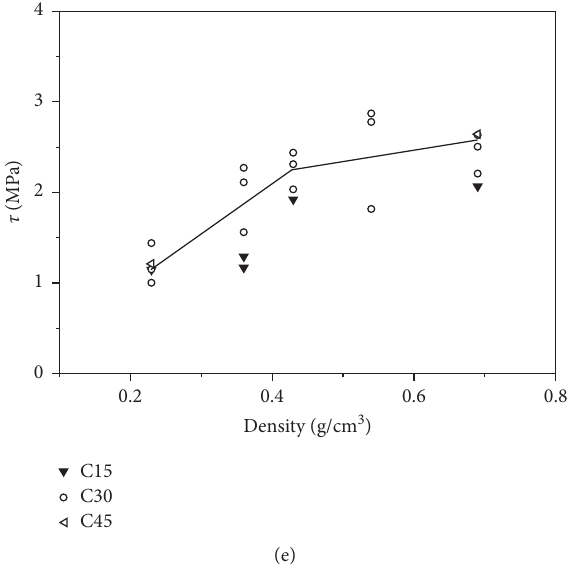
Figure 5: Relationship between bond strength and polymer density. (a) C30-1; (b) C30-2; (c) 0.0 MPa; (d) 1.0 MPa; (e) 2.0MPa.